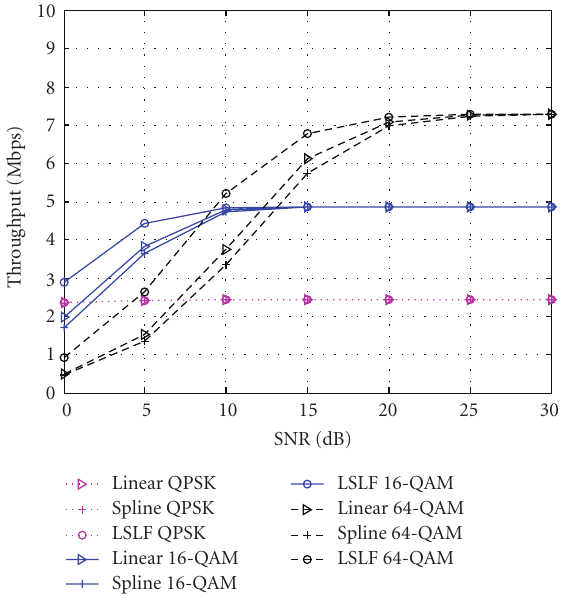
Figure 12: Throughput in Veh.A 30km/h using channel tracking.